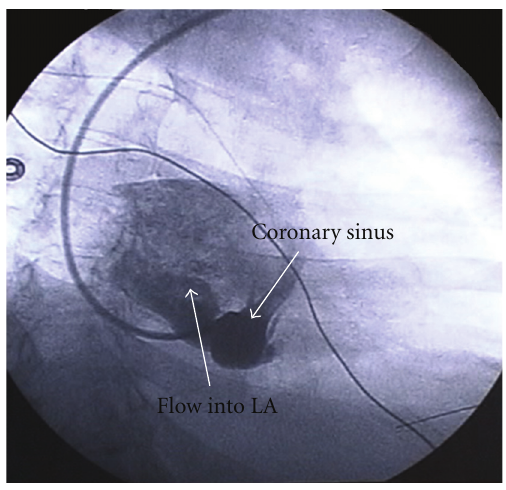
Figure 5: Coronary Sinus Venogram demonstrating an enlarged CS with communicating vessel into LA.